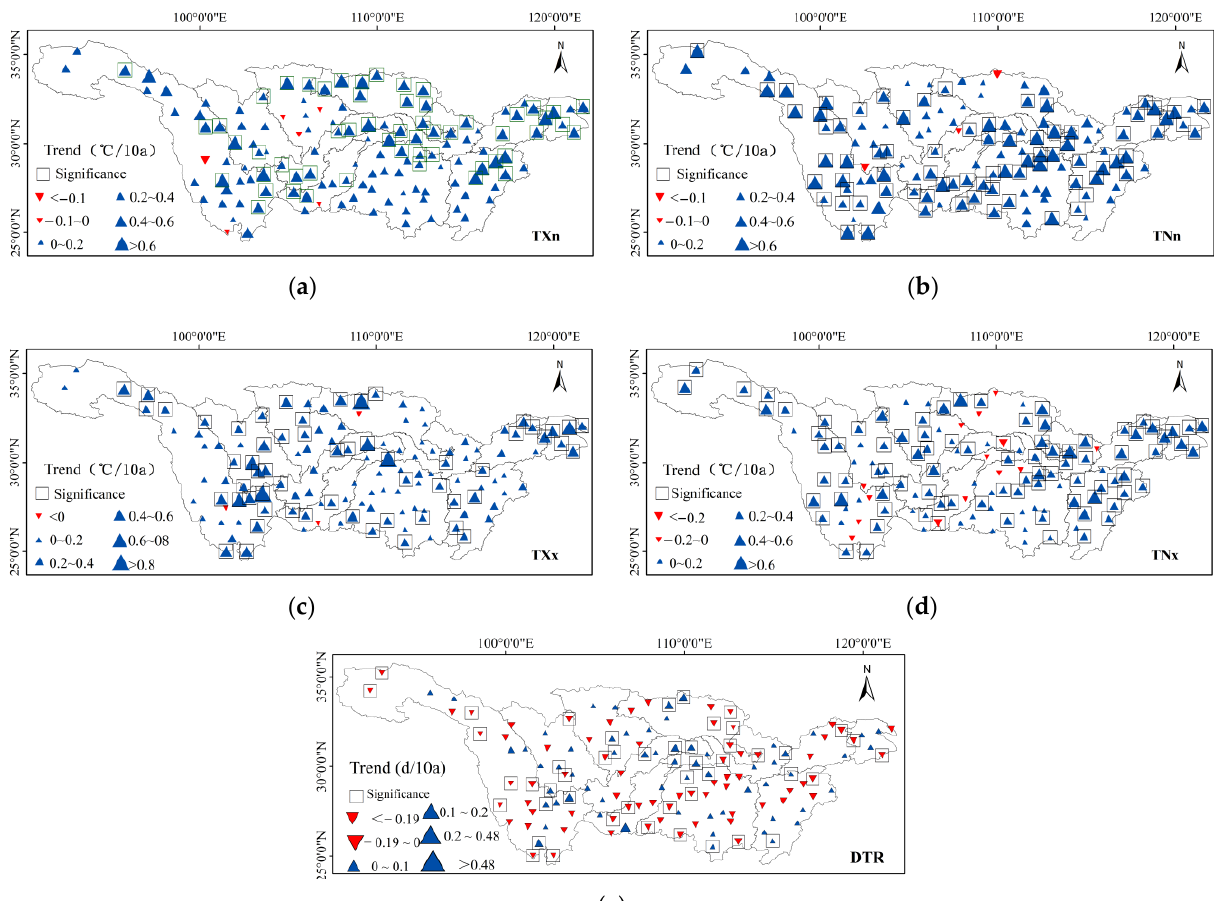
Figure 7. Spatial distribution of extreme indices of extreme temperatures in the Yangtze River Basin from 1970 to 2014. ( a ) is TXn, ( b ) is TNn, ( c ) is TXx, ( d ) is TNx and ( e ) is DTR.